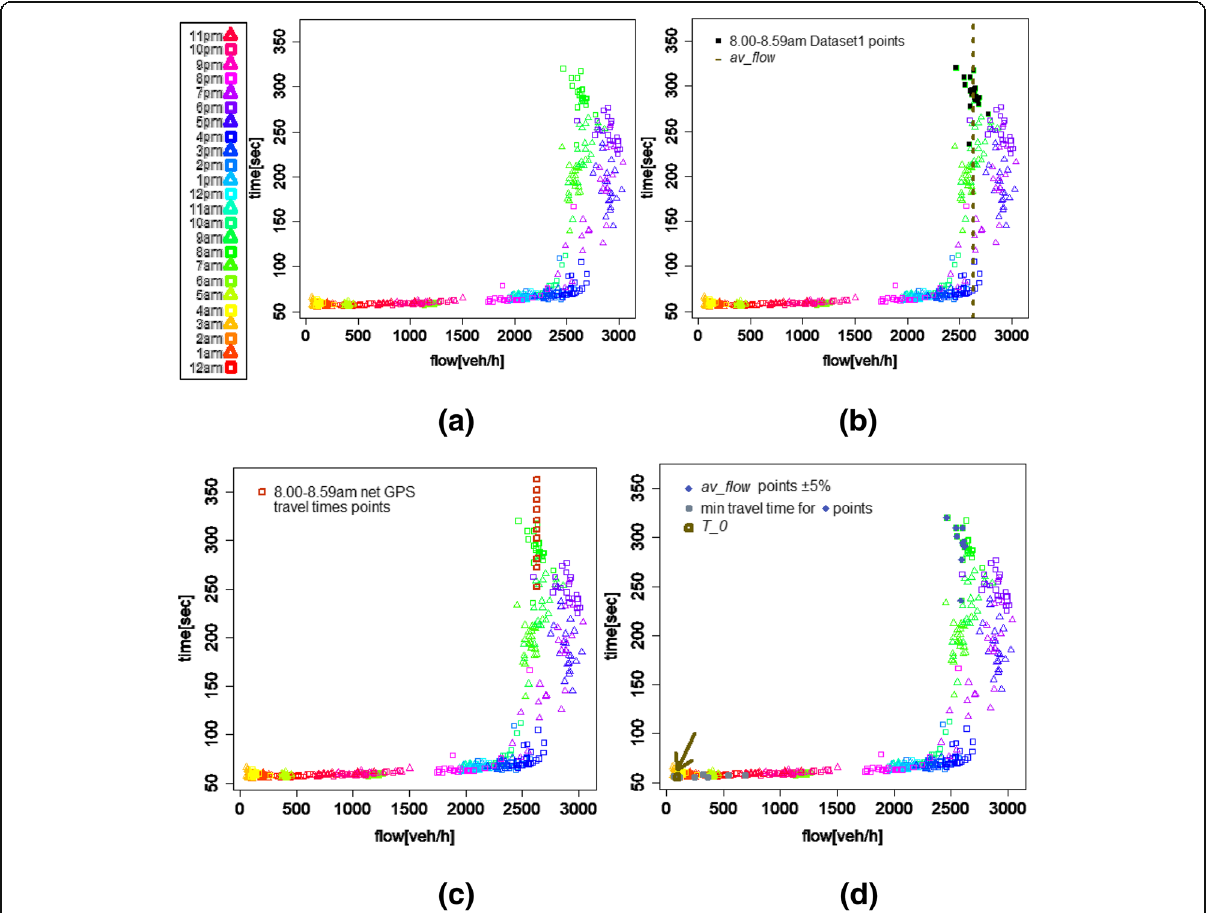
Fig. 1 Visualisation of the different steps of the methodology: ( a ) scatterplot of flow (number of vehicles/hour) versus travel time for a selected arc, ( b ) selection of experimental points within the time range 8:00 – 8:59 am, ( c ) the search for GPS travel time values, with focus on the same time range, ( d ) the search for free flow travel time value T_0 . The legend is available on the top left part of the